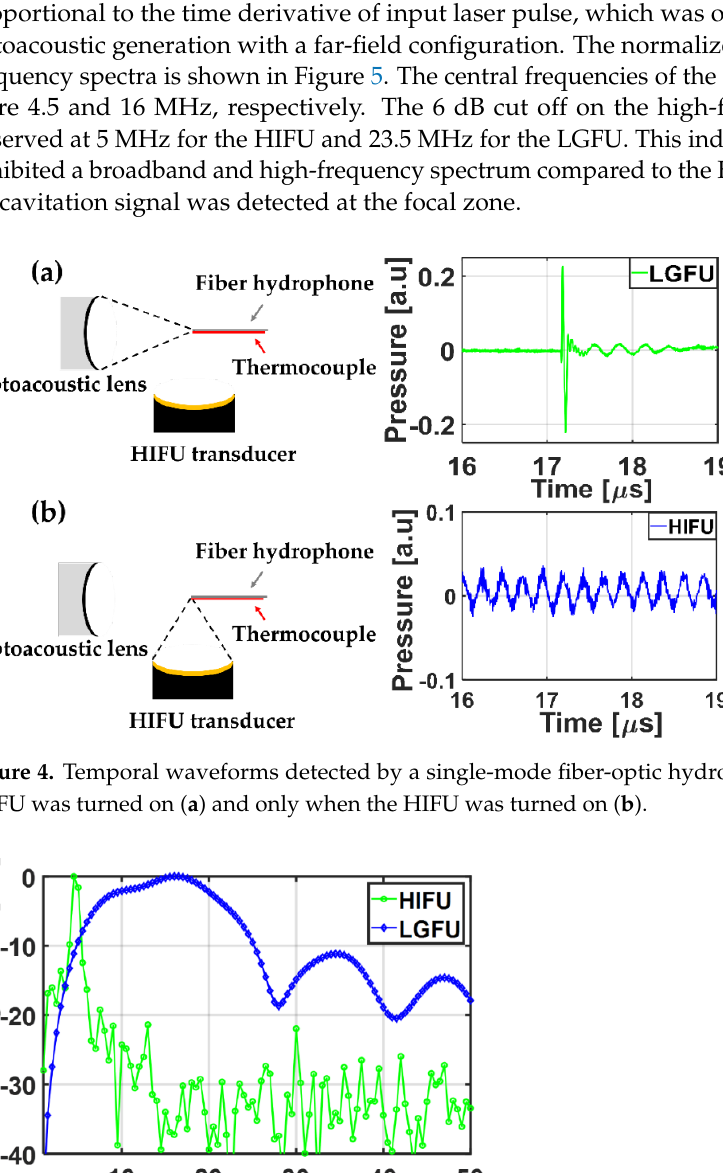
Figure 6. Combined waveforms of the LGFU and the HIFU are shown with negligible temperature enhancement in ( a ) (less than a few °C) and 9 °C enhancement in ( b ). While peak amplitudes of the LGFU and the HIFU were fixed for both figures, the duty cycle of the HIFU transducer was applied differently. For both operations in ( a , b ), temporal waveforms were recorded using the fiber-optic hydrophone after the temperature measurement. Next, we compared cavitation probabilities for different LGFU and HIFU conditions (Figure 7). The probability was obtained by dividing the number of cavitation occurrence at focus by the number of input laser pulses. LGFU was produced by the optoacoustic lens with an input laser pulse energy of E . Here, E th is defined as a single-pulse laser energy to generate the focal pressure near the onset of cavitation (not the cavitation threshold of 50% probability). The operation with LGFU alone produced cavitation with a 6.1% prob- ability (98 out of 1600 pulses) at E = E th which was 4.35 mJ/pulse. The chances of cavitation occurrence significantly increased by using the dual focusing of LGFU and HIFU. As the focal zone of the LGFU increased by 9 °C, the cavitation probability significantly im- proved to 17.5% (140 out of 800 pulses). The focal zone of the LGFU was completely in- cluded by that of the additional low-frequency HIFU with the 83-fold greater volume. This was further enhanced up to 36% (288 out of 800 pulses) in the 13 °C enhancement condition. These results also suggest that even a lower laser energy than E th can be used to produce cavitation as long as the focal zone is sufficiently heated. For this purpose, we reduced the input laser energy to 3.78 mJ/pulse which corresponds to a sub-threshold re- gime for the original value of E th . With this laser energy, the LGFU alone did not produce